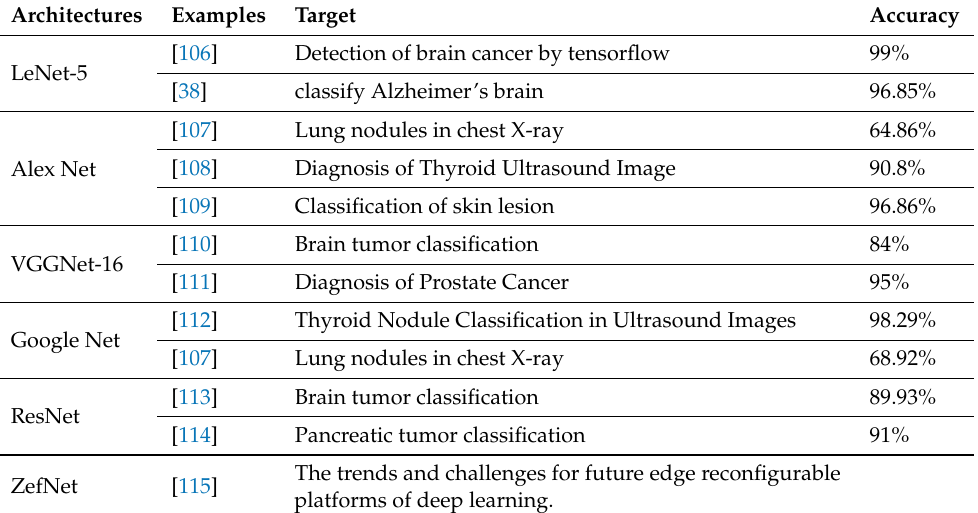
Table 6. Architectures of CNN and their